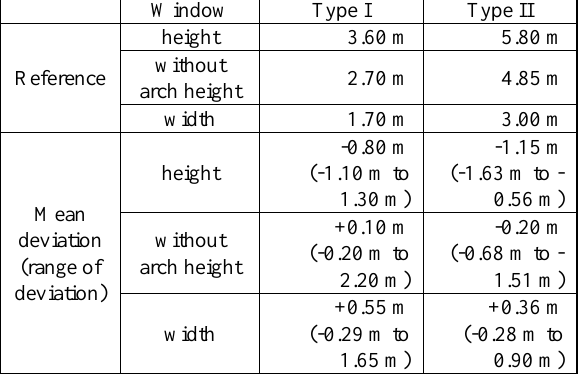
outline hypothesis and so for the whole reconstruction process.